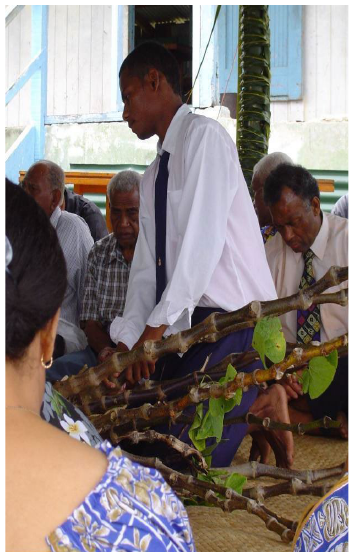
Figure 2: Year 12 student at Richmond Methodist High School, Kadavu, Fiji, presents yaqona to dignitaries at the opening of the annual school fundraising event (photographer: Apo Aporosa, 2008)